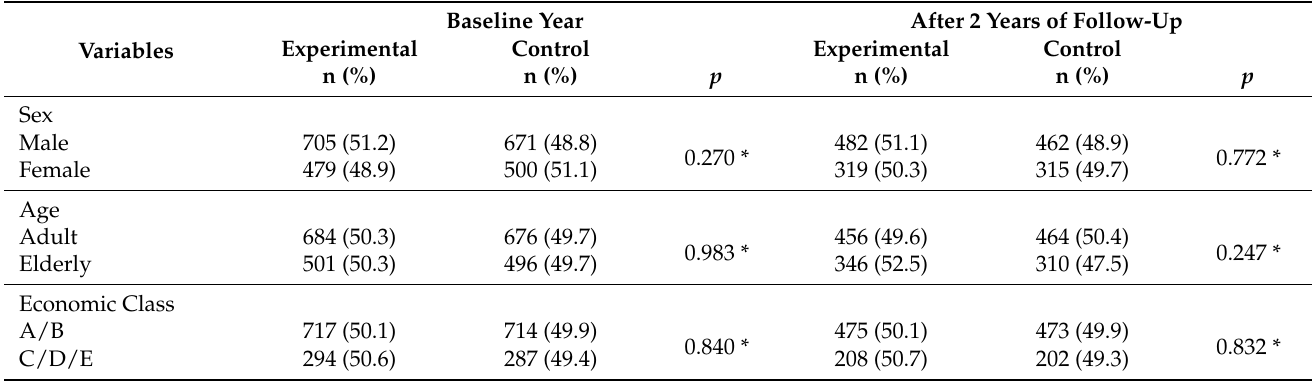
Figure 1. Eligibility, randomization and follow-up of the participants. Table 1. Sociodemographic and health characteristics of individuals in the secondary prevention for CVD at the initial time and after the second year of follow-up of the BALANCE program (n =